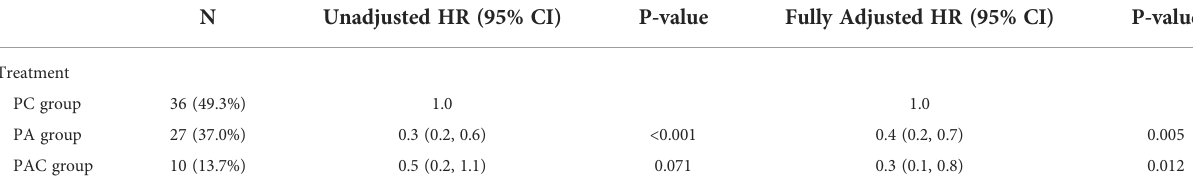
TABLE 4 Unadjusted and adjusted cox proportional hazards model for disease progression.